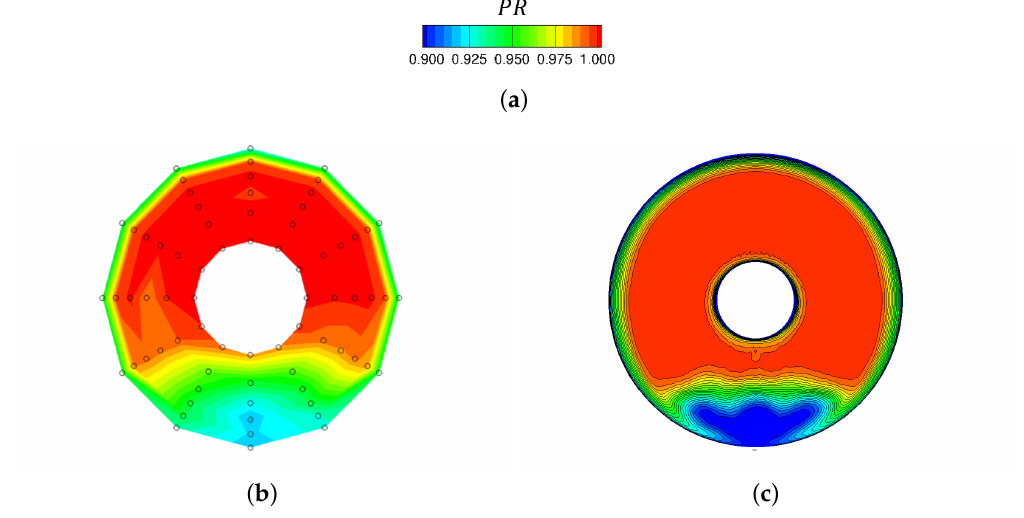
Figure 6. Experimental and simulated engine face pressure ratio. NASA grid was used with SARC-DDES turbulence model. CFD data are time-averaged from 2 to 2.5 s of simulation time. ( a ) Pressure recovery range; ( b ) Experimental data; ( c )